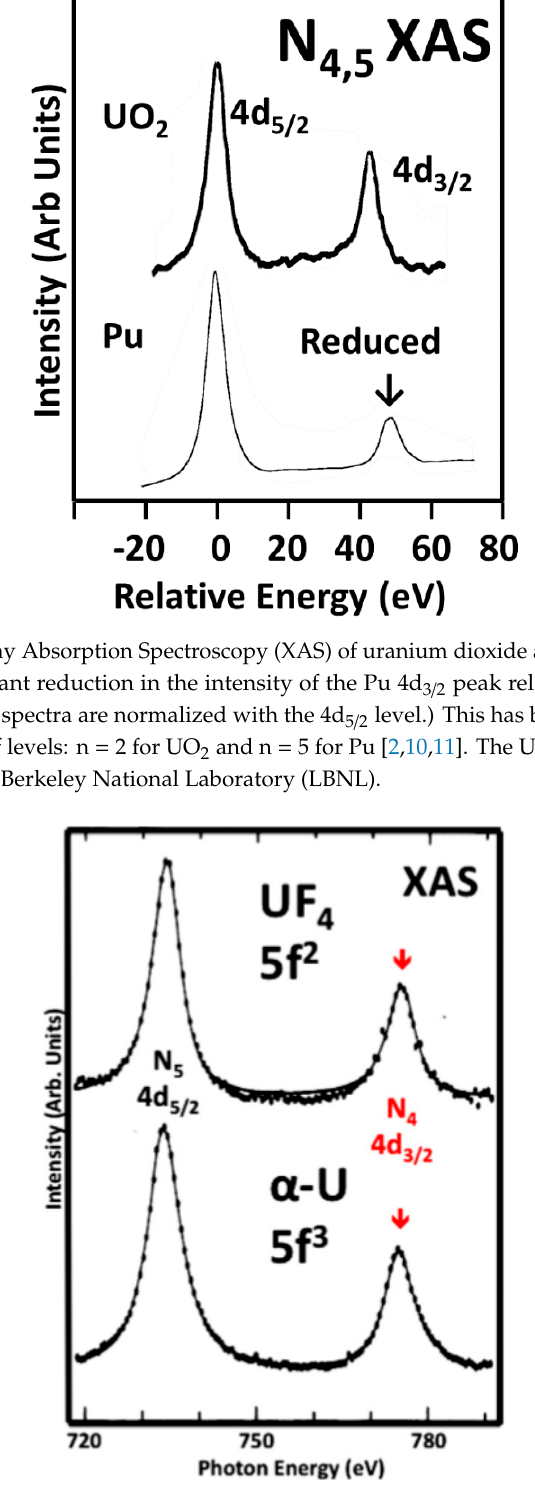
Figure 2. The N 4,5 XAS spectra of UF 4 and α -U are shown here, analogous to Figure 1. UF 4 is a localized n = 2 system, very similar to UO 2 . [2] The data are originally from Kalkowski, Kaindl, Brewer and Krone. [21]. The figure is reproduced from [27]. Note that the two spectra cannot be distinguished; they have the same BR.